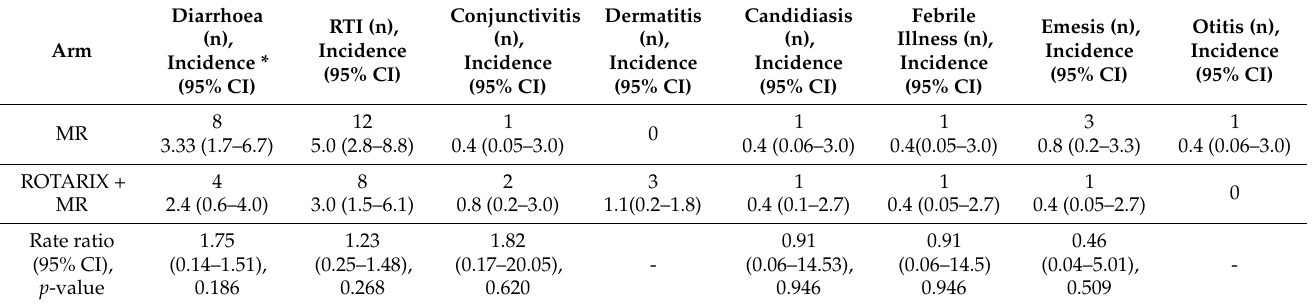
Table 3. Incidence of adverse events within 1 month after third dose ROTARIX ® (+MR) compared to MR